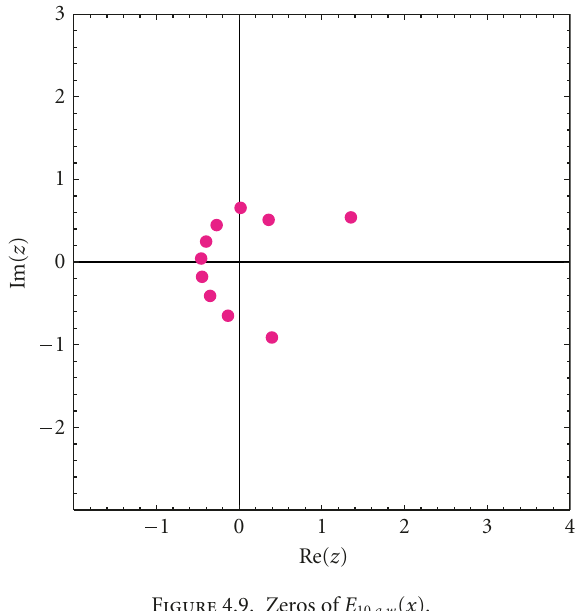
Figure 4.9 . Zeros of E 10, q , w ( x ).